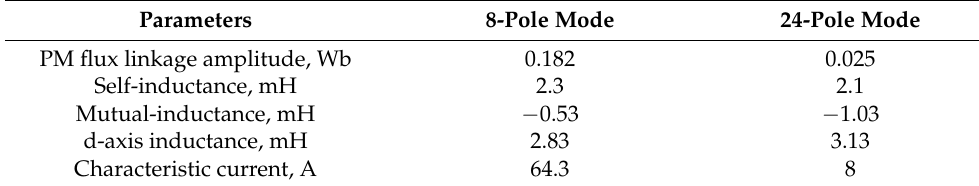
Table 2. Calculated PM flux linkage and winding inductances.